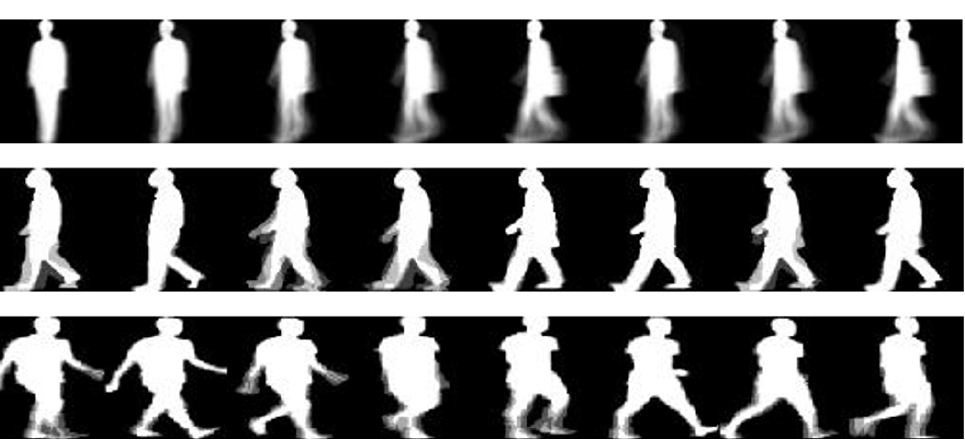
Figure 1. Sample gait